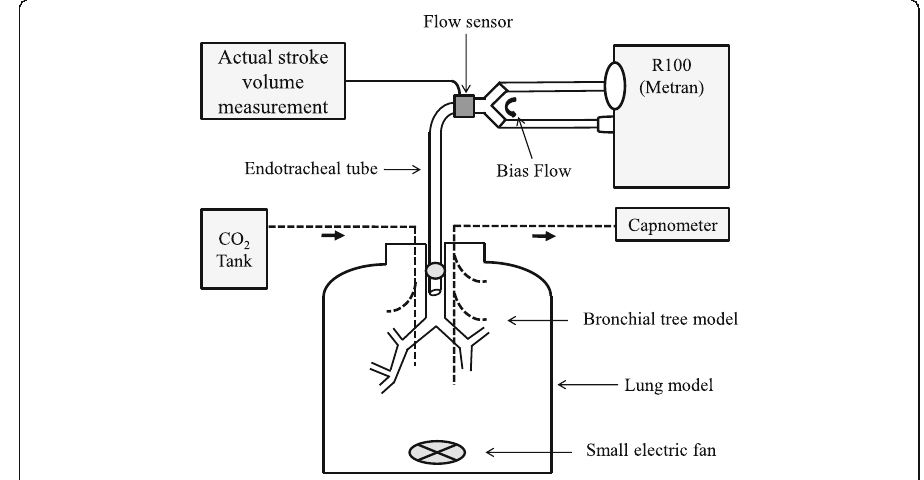
Fig. 1 Schema of the experimental setting. Legend: For more information, see the